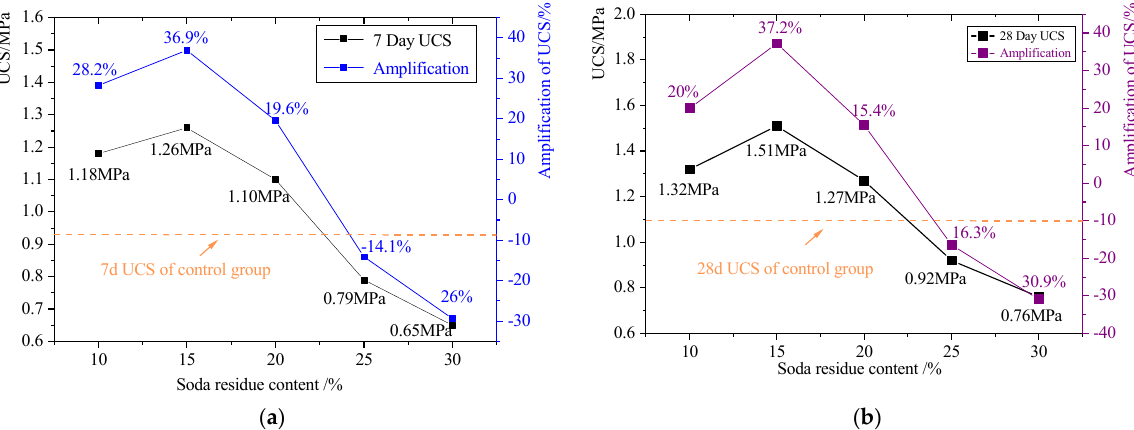
Figure 7. SR content–UCS curve. ( a ) 7–day maintenance period; ( b ) 28–day maintenance period.